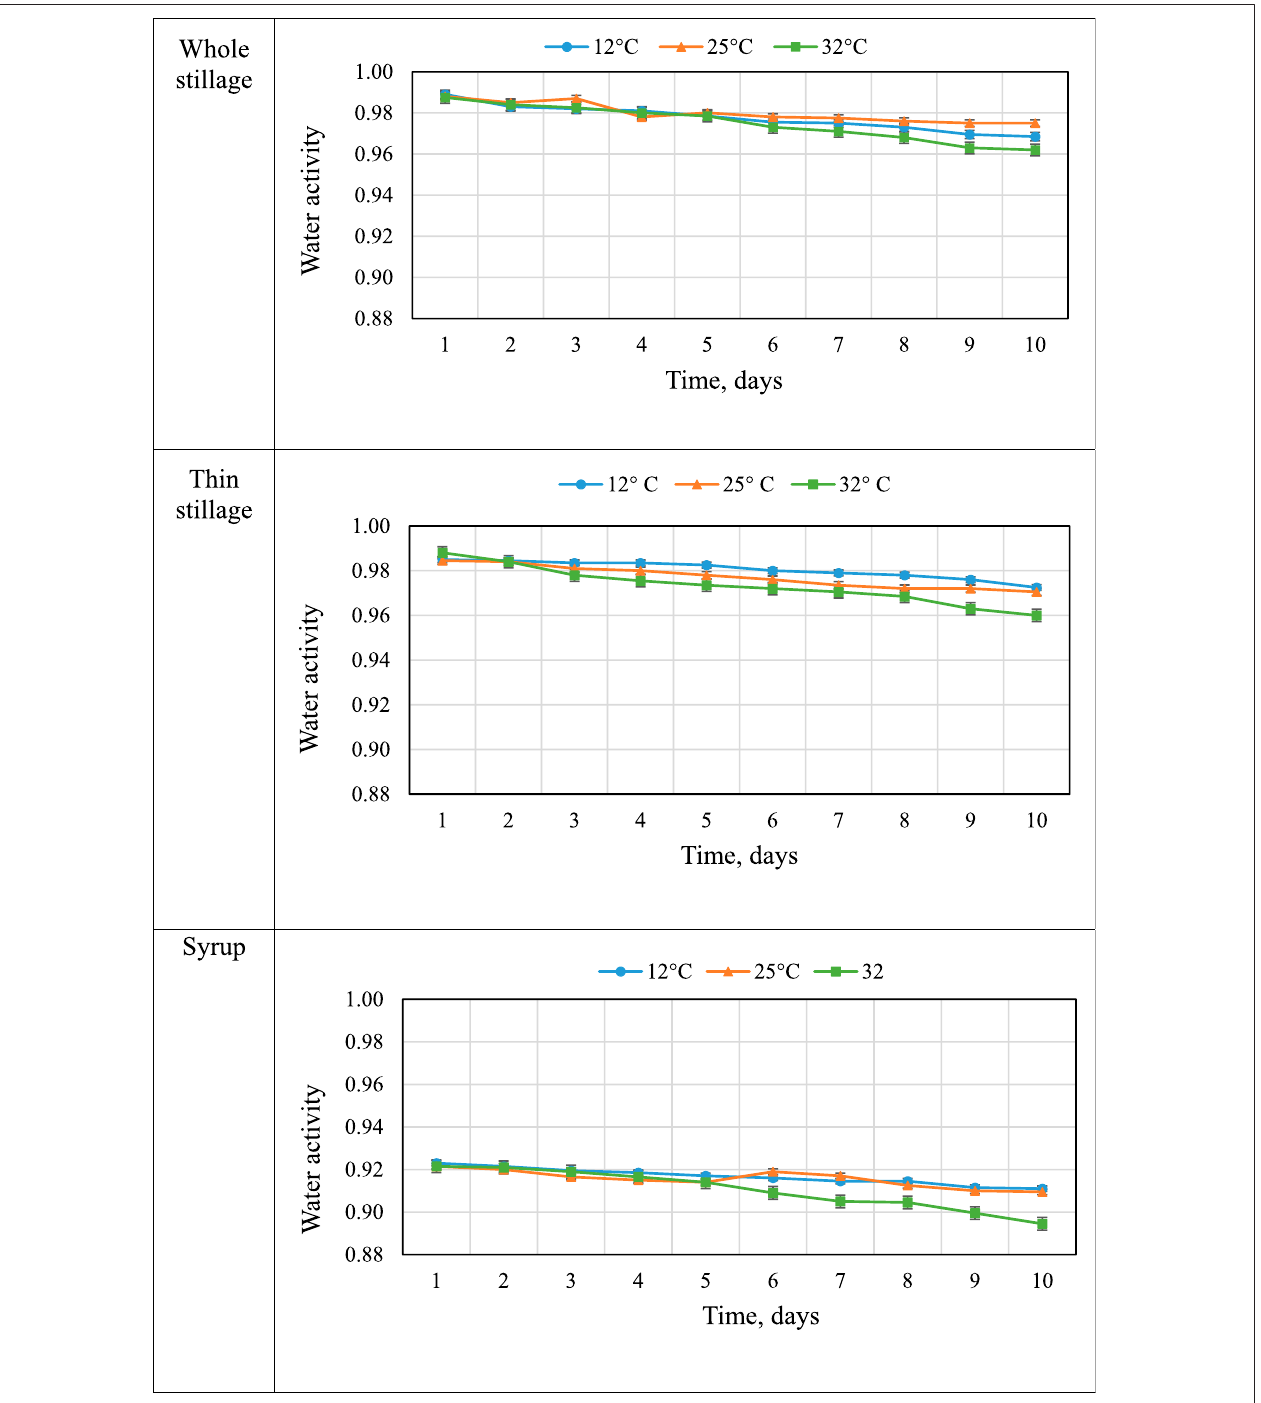
FIGURE 5 | Mean water activity changing over time. Error bars denote 1 standard